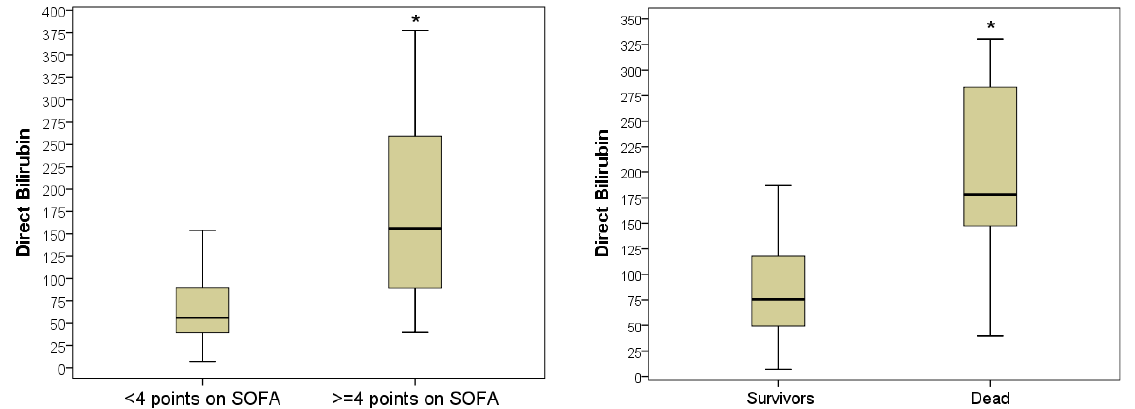
Figure 4. Indicator of direct bilirubin in hospitalization of severe and non-severe patients, as well as in favorable and unfavorable hospital outcomes (* — difference between the two groups according to the Mann – Whitney criterion at p < 0.05).